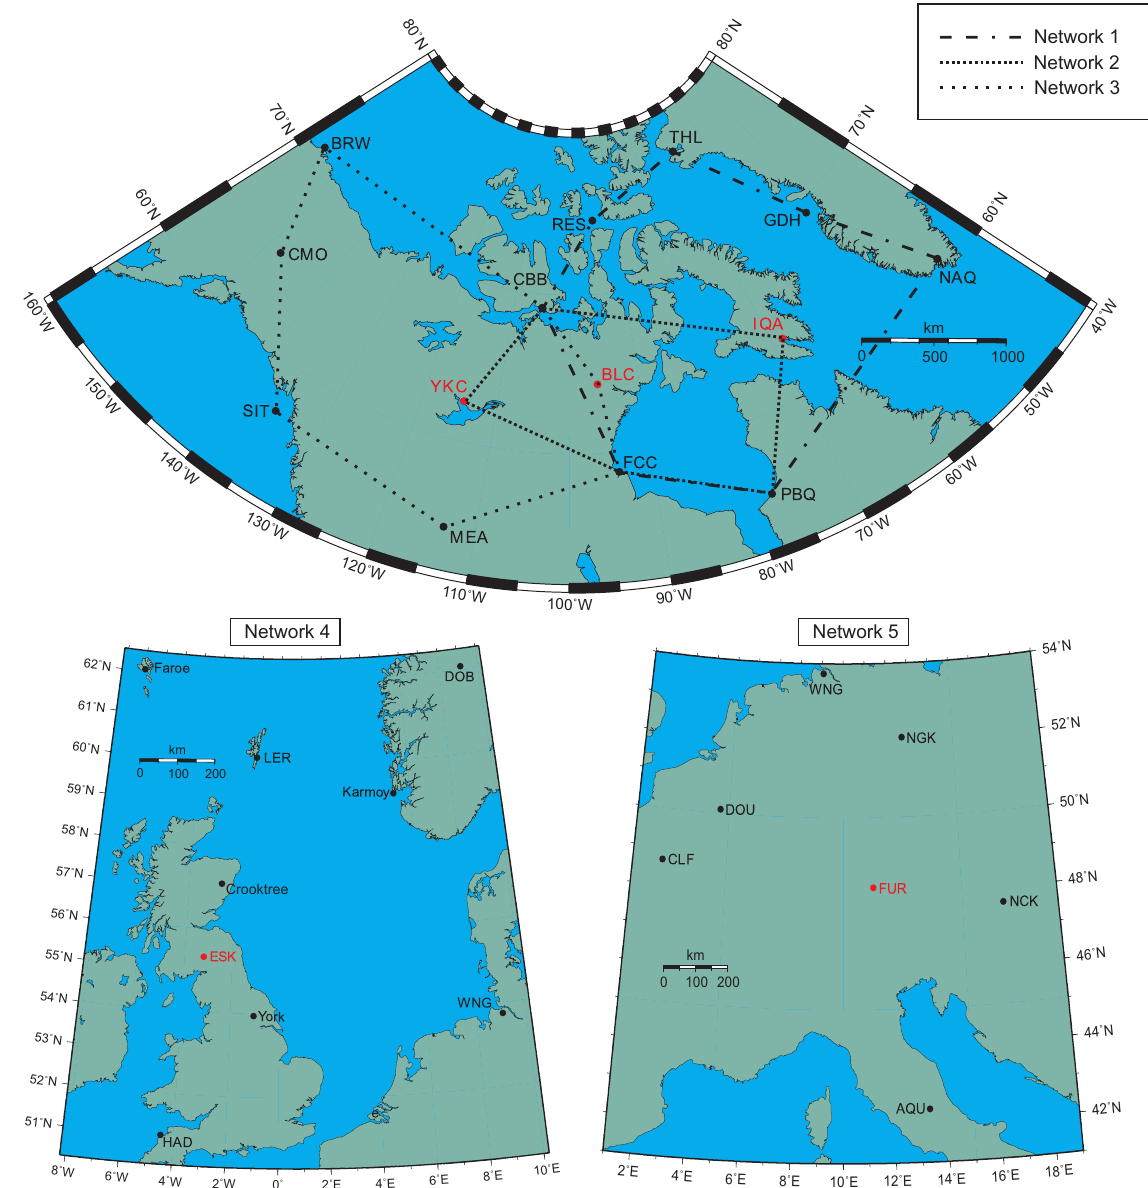
Fig. 1. Geographical arrangement of the five networks of magnetic observatories used in this study. The observatories used for comparison (denoted in red) for each network are: Network 1: IQA (Iqaluit); Network 2: BLC (Baker Lake); Network 3: YKC (Yellowknife); Net- work 4: ESK (Eskdalemuir); Network 5: FUR (Furstenfeldbruck). Observatories are denoted with the upper-case IAGA three-letter code. Variometers in Network 4 are denoted by their full